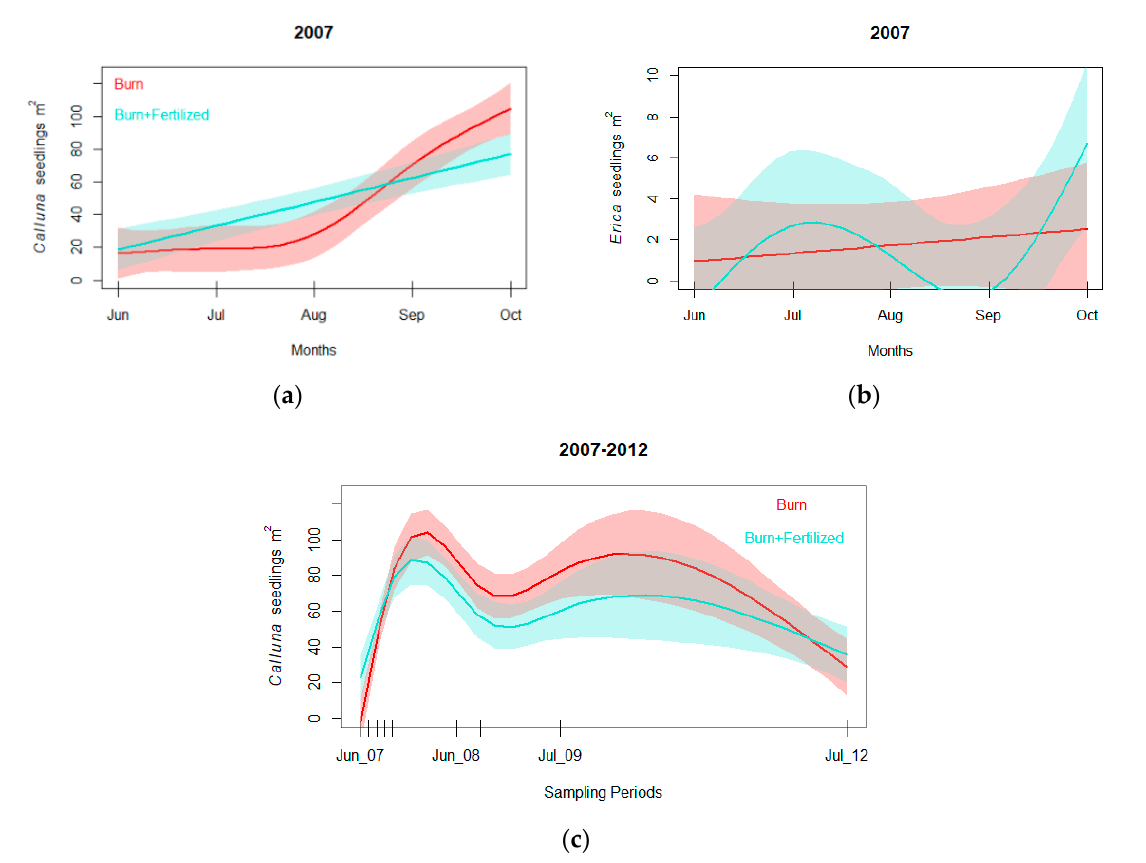
Figure 3. Germinated seedlings number for Calluna and Erica after burning of heathlands in the Cantabrian Mountain range during the growing season of 2007 (June–October) and for Calluna during all the studied period (2007–2012). The fitted line represents the best GAMM and the 95% confident intervals: ( a ) Calluna vulgaris seedlings in 2007; ( b ) Erica tetralix seedlings in 2007; ( c ) Calluna vulgaris seedlings across all the studied period. Red, burn treatments; turquoise, burned + fertilized treatment.